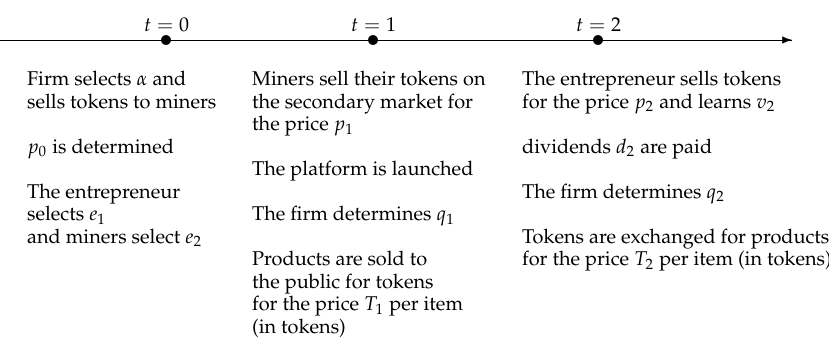
Figure 5. The sequence of events with moral hazard and market uncertainty for utility tokens with profit